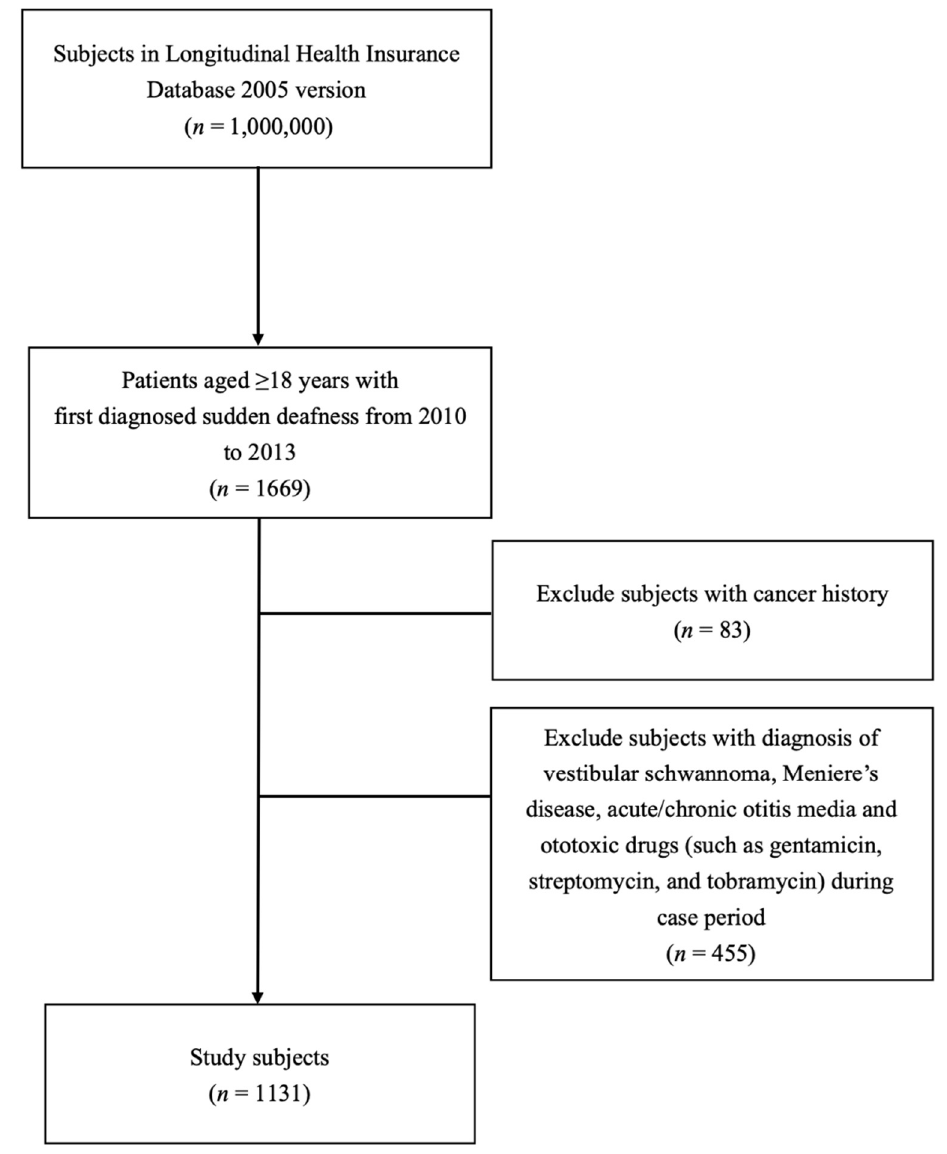
Figure 2. Flowchart of the study.